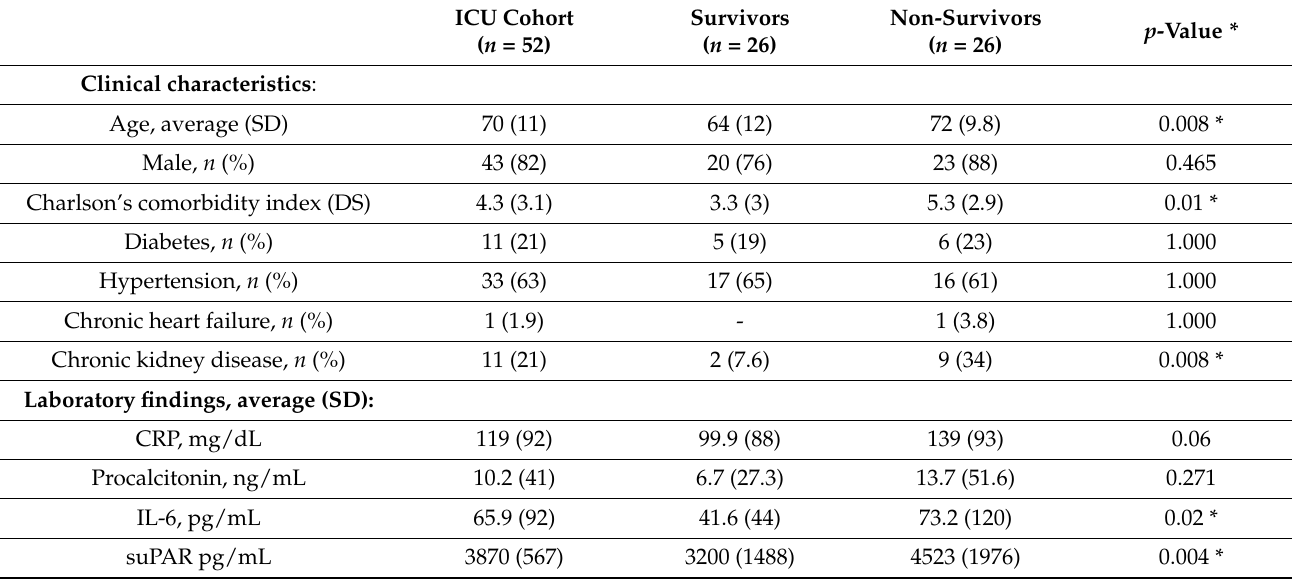
Table 2. Clinical characteristics and laboratory data of ICU patients during the Italian second wave. ICU